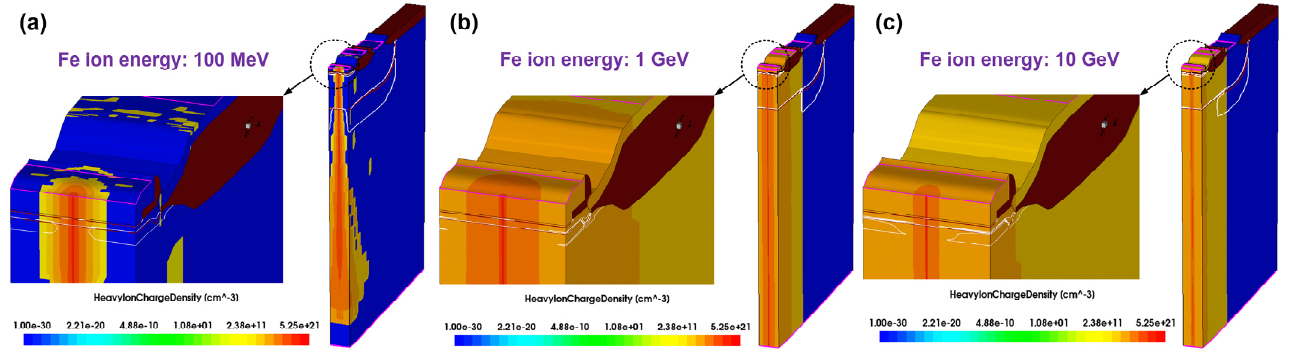
Figure 9. The EHPs’ distribution of the TCAD simulation produced by incident Fe ions of different energies ( a ) 100 MeV, ( b ) 1 GeV and ( c ) 10 GeV. For a clearer comparison, the charge densities are adjusted to the same scale range.